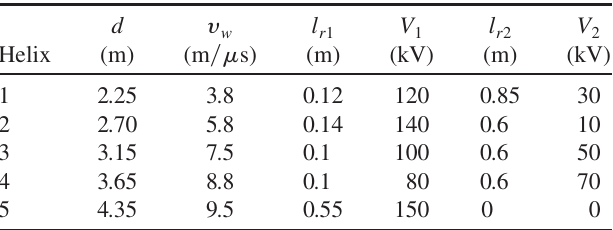
TABLE I. Parameters of each helix